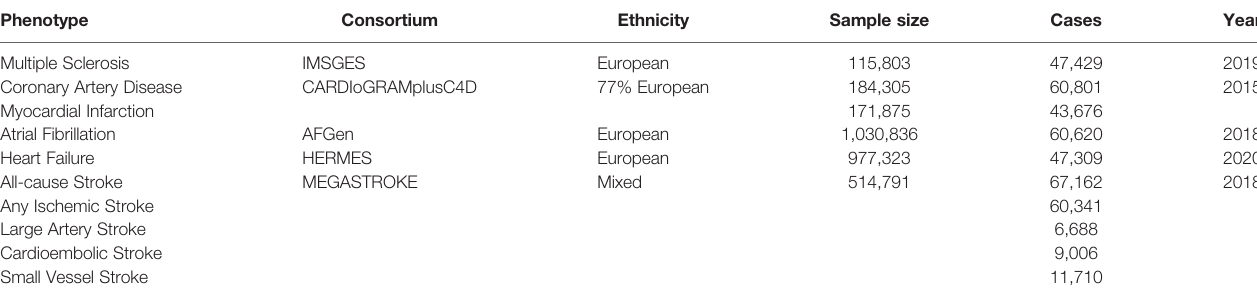
TABLE 1 | Detailed information of the studies and datasets used for Mendelian randomization